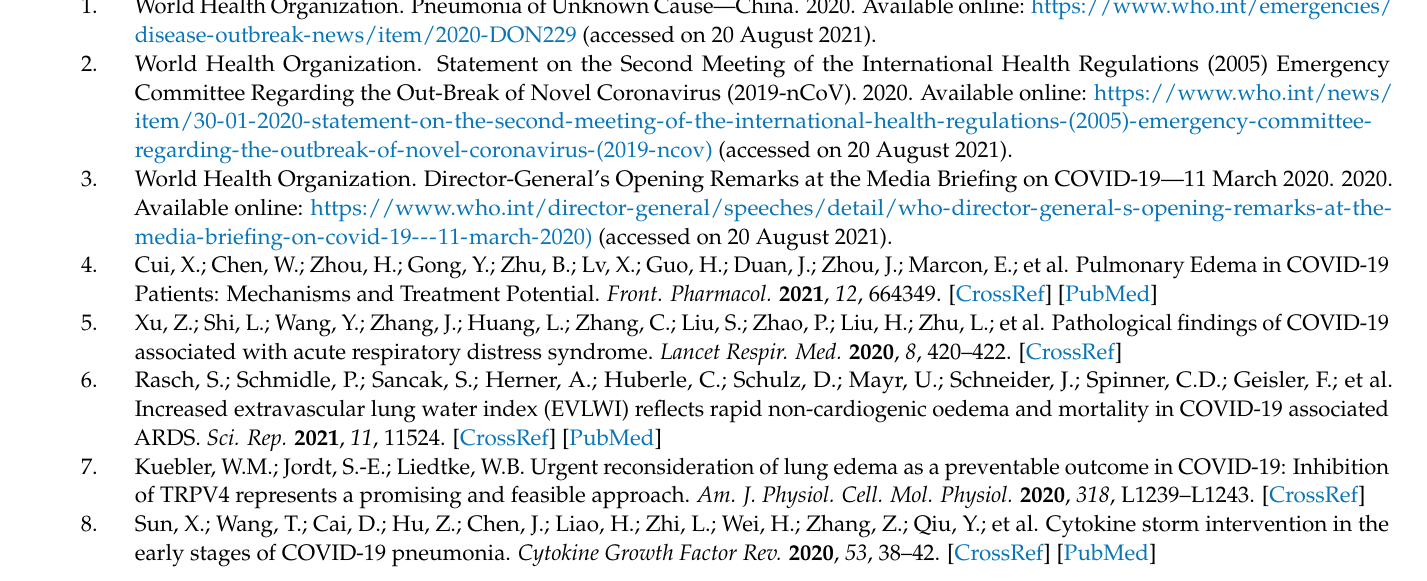
discharge, Table S5: Serum sodium levels at ICU admission and day 7, Table S6: Serum potassium at ICU admission and day 7, Table S7: Computed Tomography (CT) score, Table S8: Superior vena cava diameter (mm) in Computed Tomography (CT), Table S9: Cardiac axis (cm) in Computed Tomography (CT), Table S10: Cardiothoracic Ratio (CTR) in Computed Tomography (CT), Table S11: Furosemide in milligrams per hour data daily evolution, Figure S1: What is hidden behind this evolution COVID-19?, Figure S2: Emerging hypothesis: First HIT, Figure S3: Emerging hypothesis: Second HIT, Figure S4: Emerging hypothesis: Third HIT, Figure S5: Emerging hypothesis: COVID 19: Three different and successive HITS, Figure S6: NEGBAL approach for emerging